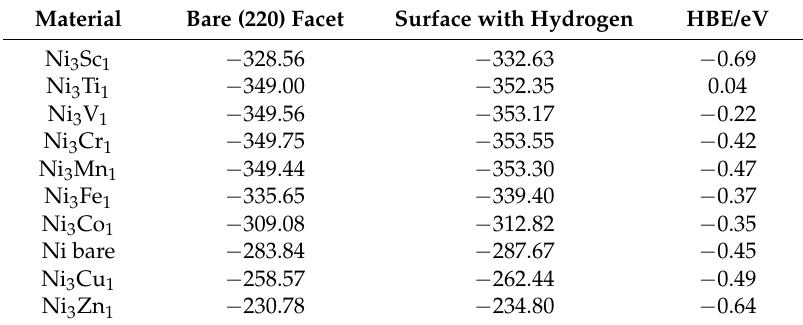
Table A3. Ground state energies of bare and with hydrogen at (220) facet (1/8 ML) supercell 2 × 2 × 1 and calculated HBE (all energies are in eVs).